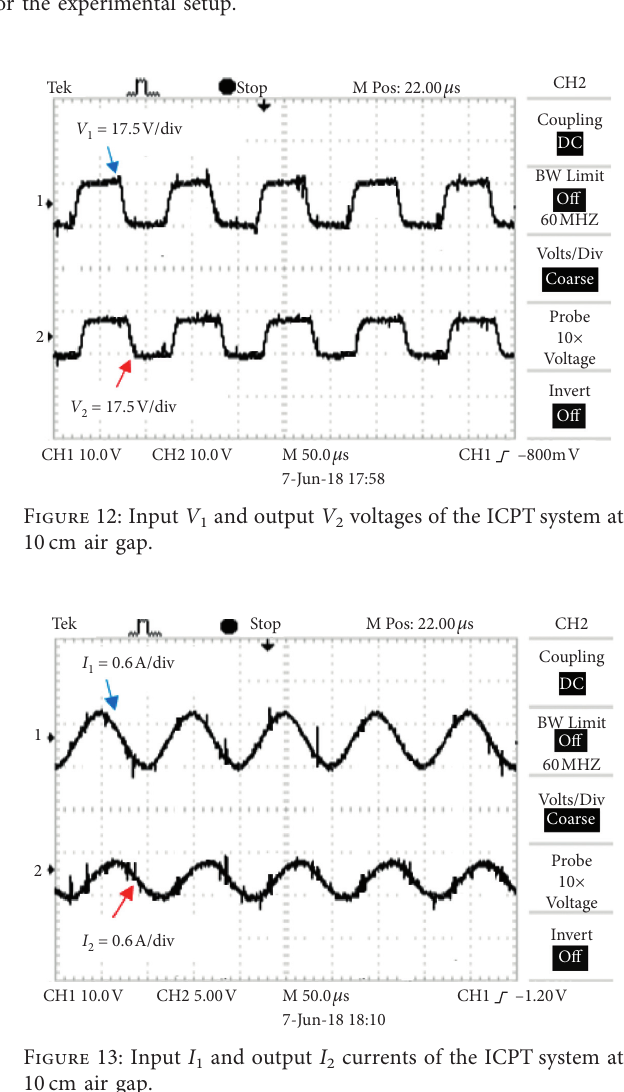
Figure 9: Scheme used for the experimental setup.